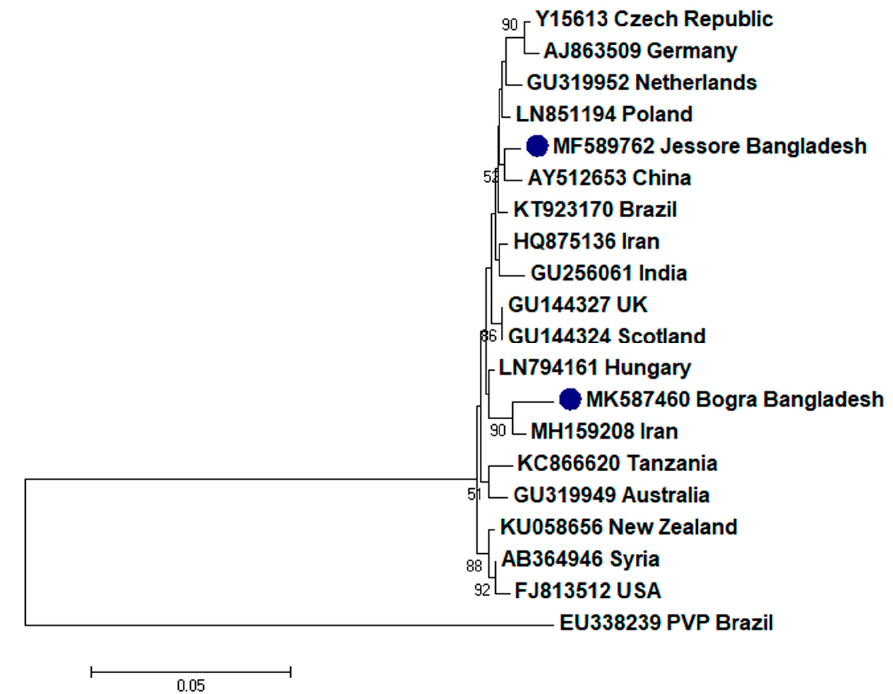
Figure 4. Phylogenetic analysis of Potato virus S detected from Bangladesh based on the coat protein gene sequences (nt) of different selected isolates from the NCBI database. The phylogenetic tree was generated by MEGA7 using neighbor-joining method with 1000 bootstrap replicates, and only values >50% are shown at the nodes. An isolate of Potato virus P (PVP) from Brazil was used as an outgroup.